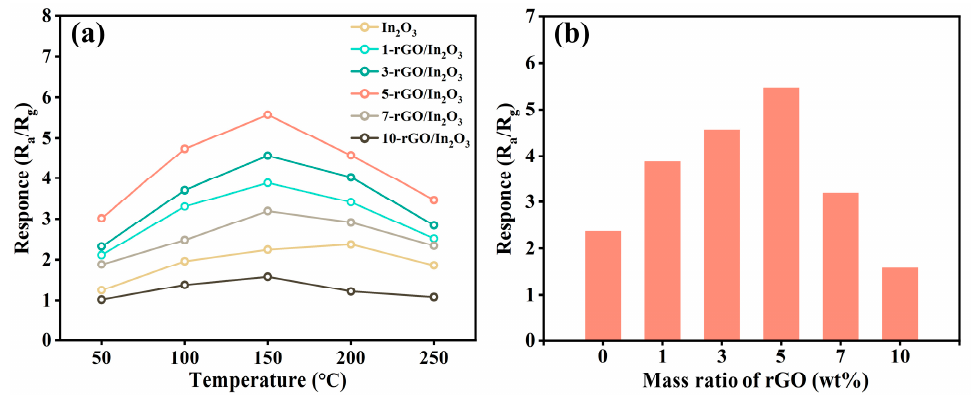
Figure 7. ( a ) The sensing response to 10 ppm acetone at various operating temperatures. ( b ) Correlations between the sensing response to 10 ppm acetone at the optimal operating temperature and rGO mass ratios.